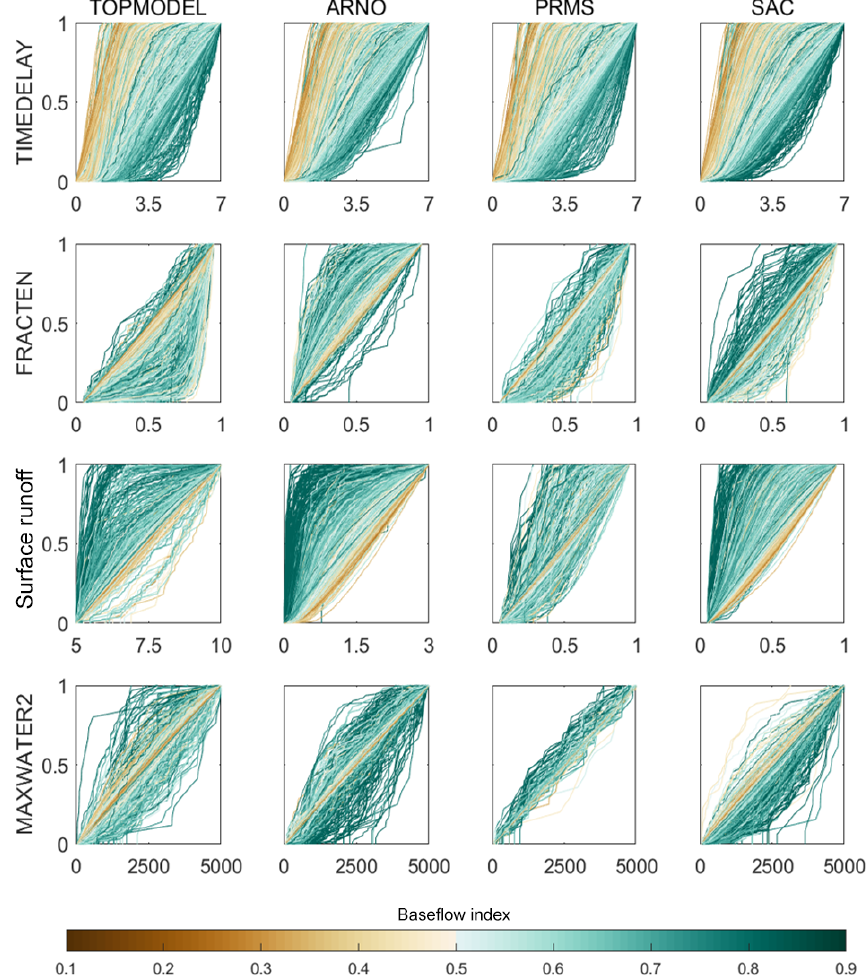
Figure 9. Cumulative distribution function (CDF) plots showing parameter values of the behavioural simulations for each catchment. Each line represents a catchment and is coloured by that catchment’s BFI. The four rows show different parameters controlling different parts of the hydrograph. Surface runoff is given by the LOGLAMB (TOPMODEL), AXV_BEXP (ARNO) and SAREAMAX (PRMS and SACRA- MENTO), as there was no common surface runoff parameter used for all four models. Each column is a different hydrological